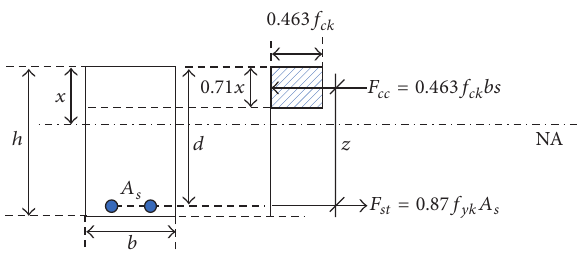
Figure 6: Equivalent stress block diagram for HSC, EC2 [16].